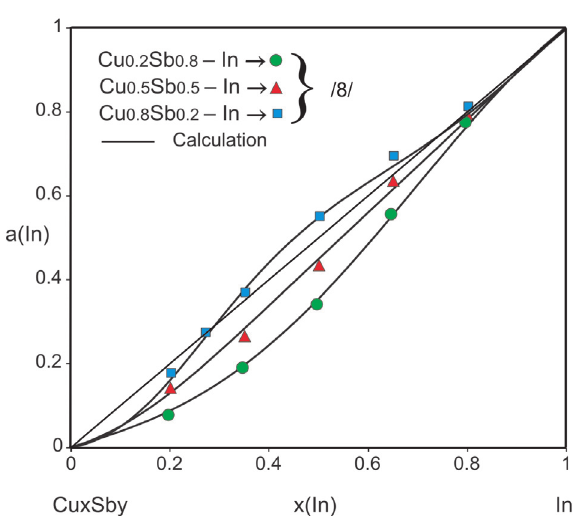
Figure 1. Comparative presentation of experimentally val- ues and calculated values for indium activities for three vertical sections at 1200